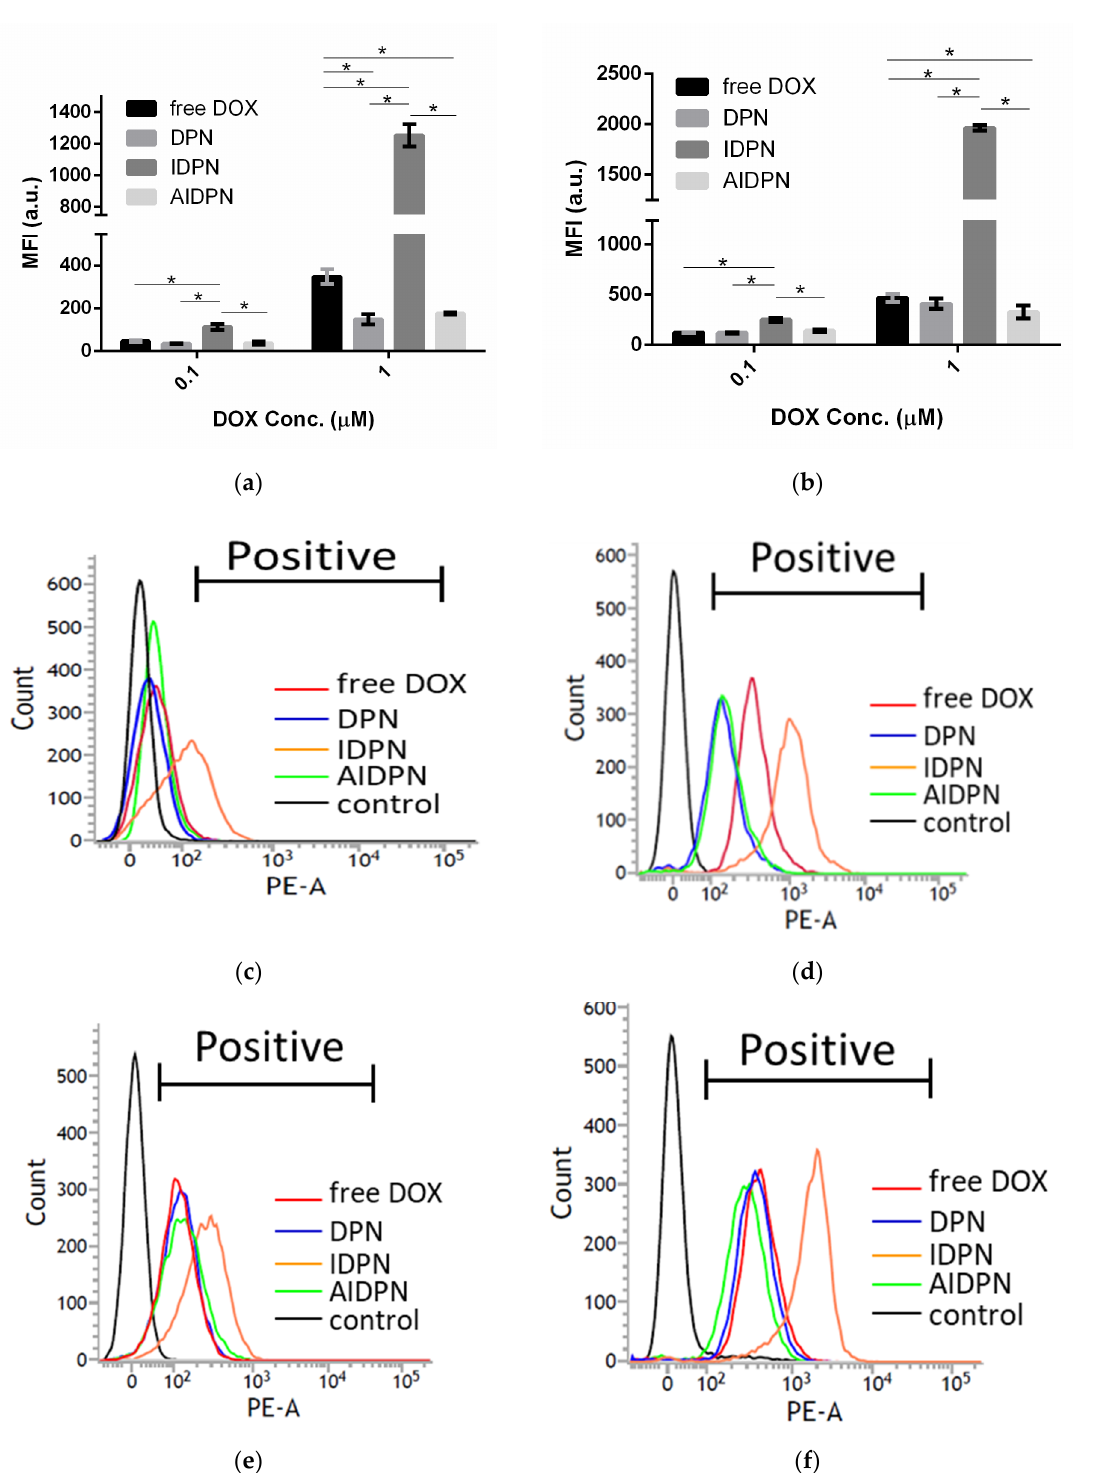
Figure 6. MFI in A549 after 0.1 and 1 μM of free DOX, DPN, IDPN and AIDPN for ( a ) 24 h and ( b ) 48 h incubation. Fluorescence intensity in A549 measured by flow cytometry after 24 h incubation of ( c ) 0.1 μM and ( d ) 1 μM of free DOX (red), DPN (blue), IDPN (orange), AIDPN (green), and control (black) and 48 h incubation of ( e ) 0.1 μM and ( f ) 1 μM of free DOX (red), DPN (blue), IDPN (orange), AIDPN (green), and control (black). Abbreviations: MFI, mean fluorescence intensity. * indicates comparison of two group, p < 0.05.